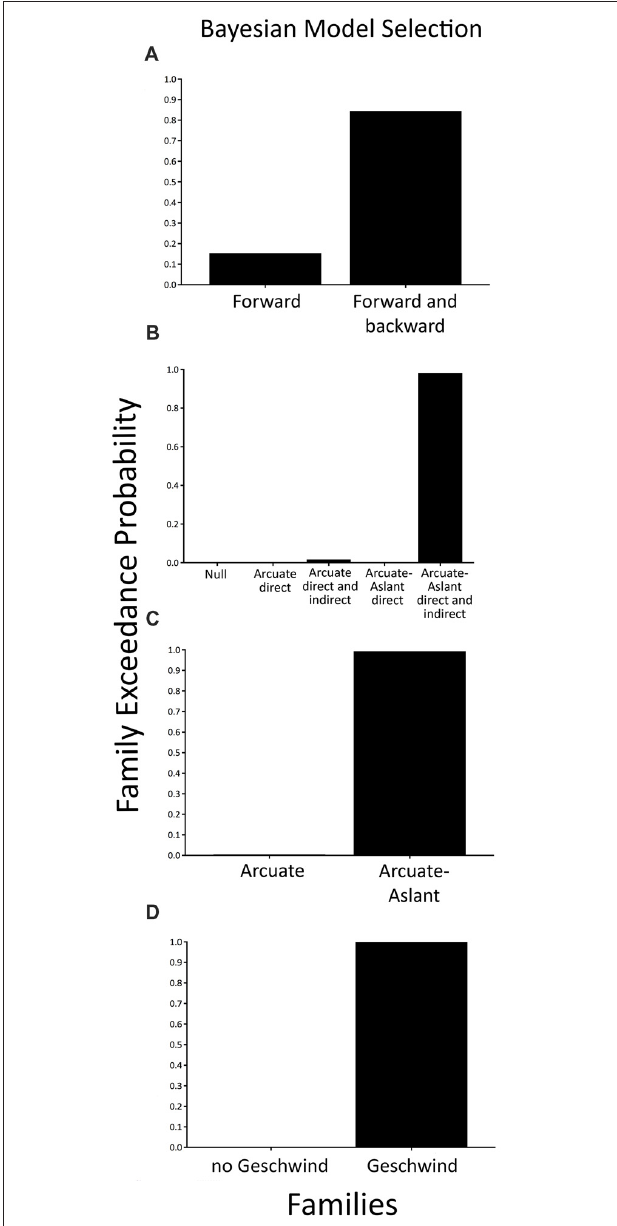
FIGURE 5 | Family-level inference for attenuation of predictable speech sounds—exceedance probabilities for the family comparisons. (A) Comparison of the Forward family (48 models) to the Forward and Backward family (48 models). (B) Comparison of five families including a Null family (eight models), the Arcuate direct pathway family (10 models), the Arcuate direct and indirect pathways family (28 models), the Arcuate-Aslant direct pathways family (14 models), and the Arcuate-Aslant direct and indirect pathways family (18 models). (C) Comparison of the Arcuate family (38 models) and the Arcuate-Aslant family (50 models). (D) Comparison of no Geschwind family (24 models) to Geschwind family (64